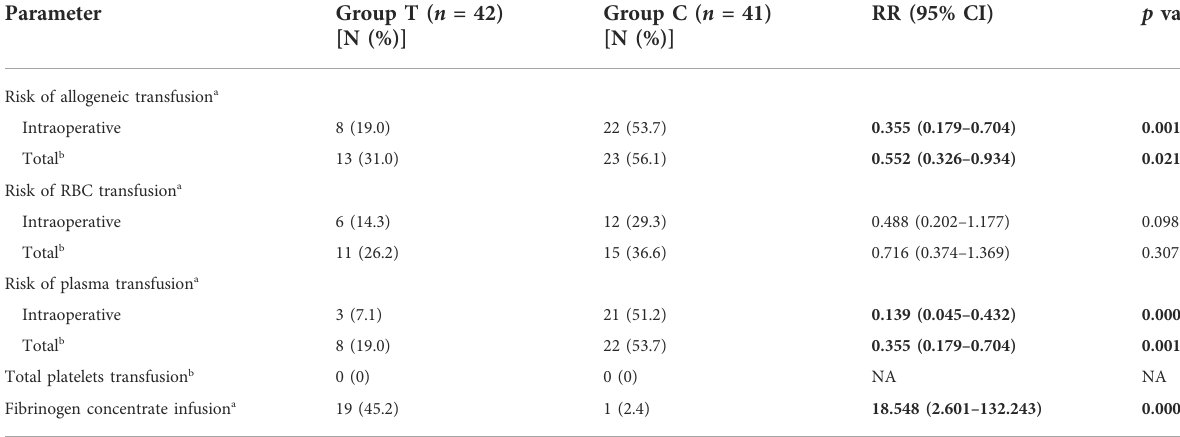
TABLE 2 Transfusion of blood products and fi brinogen